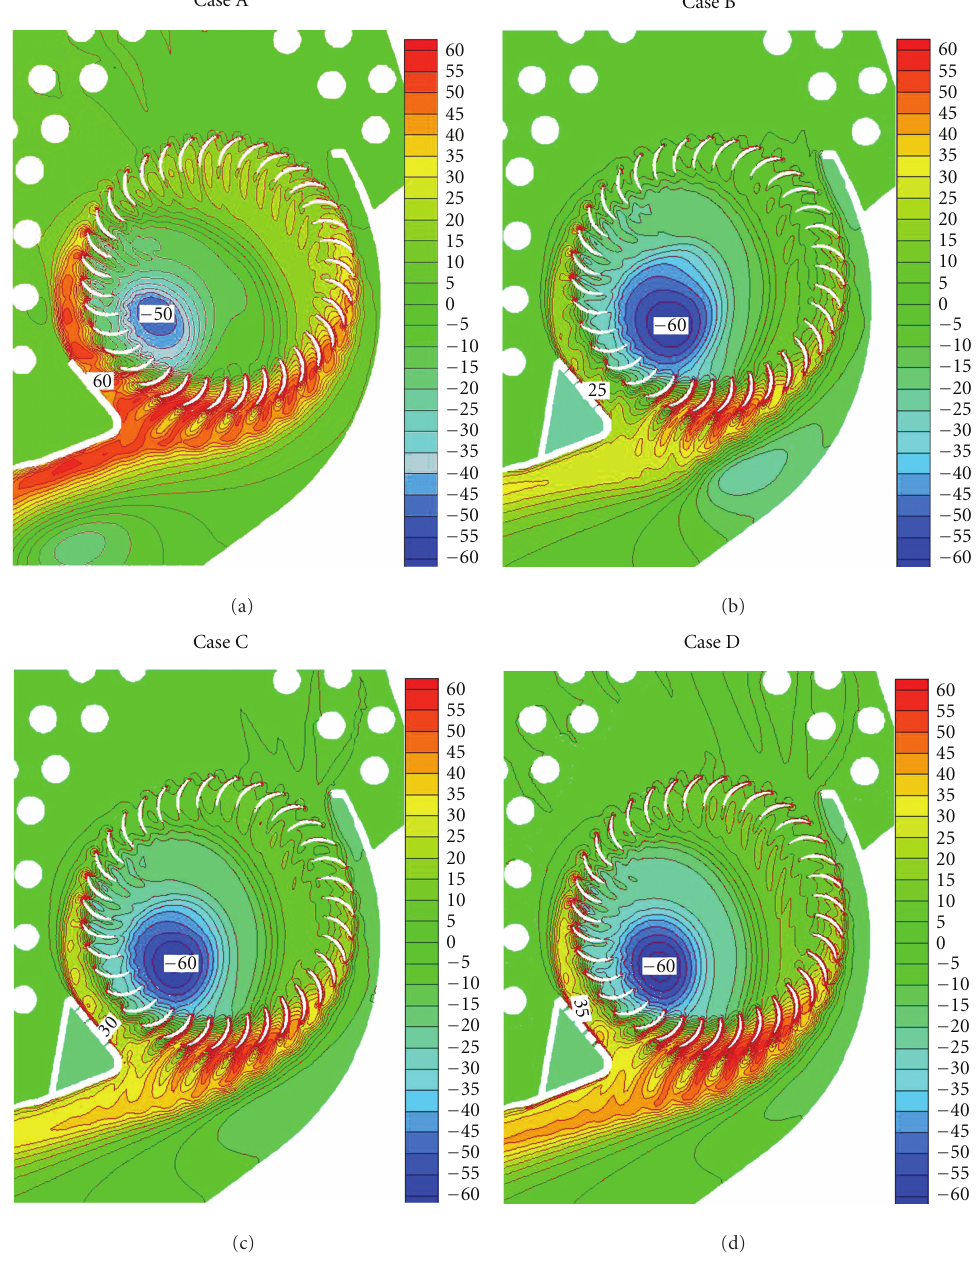
Figure 11: Contours of stagnant pressure for the CFF using porous